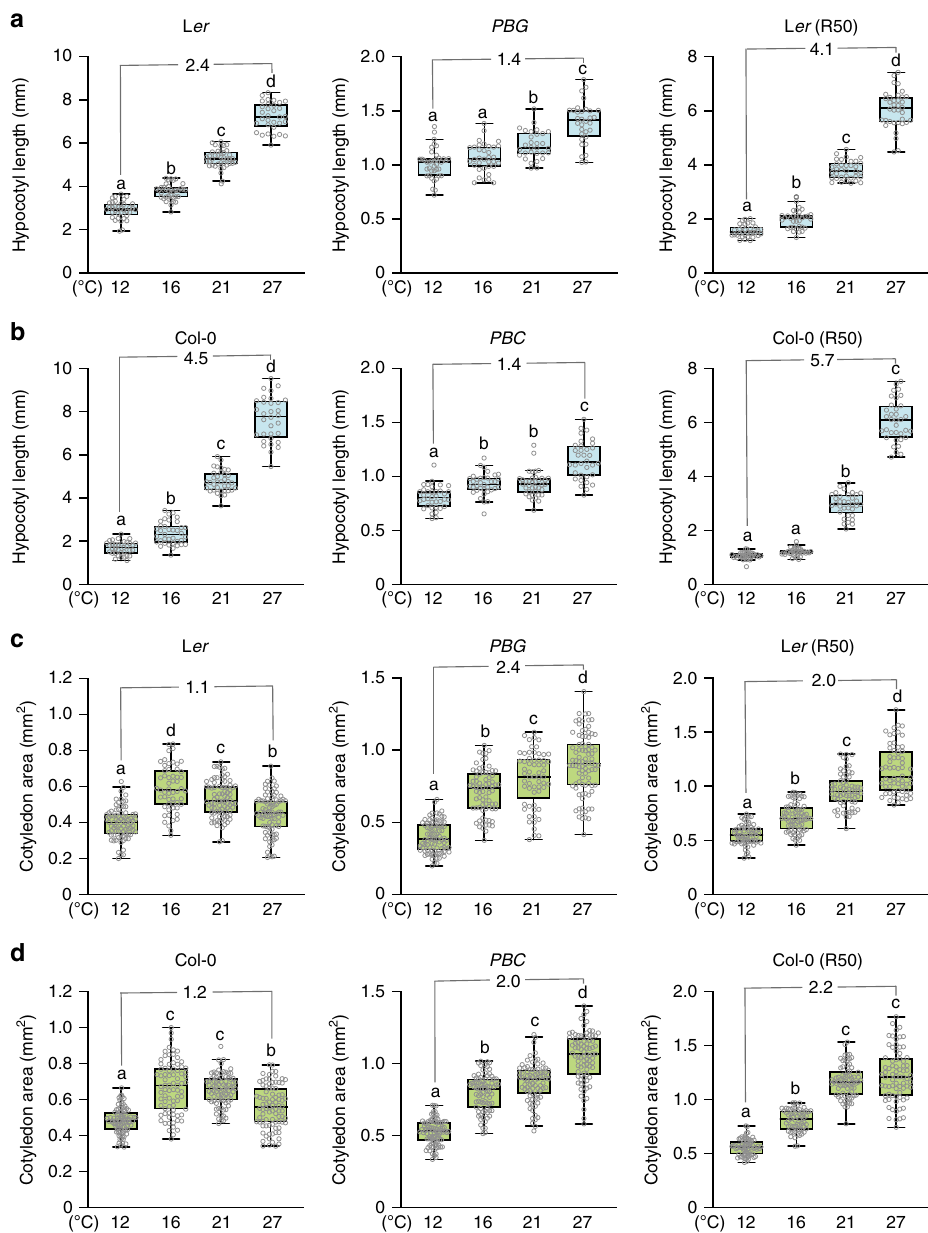
Fig. 1 Temperature imposes opposite effects on phyB functions in hypocotyl and cotyledon. a , b Warmer temperatures attenuate the function of phyB signaling in inhibiting hypocotyl growth. Hypocotyl length measurements of 4-day-old seedlings of L er and PBG ( a ) and Col-0 and PBC ( b ) grown under 10 or 50 (R50) µ mol m − 2 s − 1 R light at 12, 16, 21, and 27 °C. c , d Warmer temperatures enhance the function of phyB signaling in promoting cotyledon expansion. Cotyledon size measurements of 4-day-old seedlings of L er and PBG ( a ) and Col-0 and PBC ( b ) grown under 10 or 50 (R50) µ mol m − 2 s − 1 R light at 12, 16, 21, and 27 °C. For a – d , the fold changes of the median values of either hypocotyl length or cotyledon area between 27 and 12 °C are shown. For the box and whisker plots, the boxes represent from the 25th to the 75th percentile and the bars equal the median values. Samples with different letters exhibit statistically signi fi cant differences (ANOVA, Tukey ’ s HSD, P ≤ 0.05, n ≥ 33). The source data underlying the hypocotyl ( a , b ) and cotyledon ( c , d ) measurements are provided in the Source Data fi